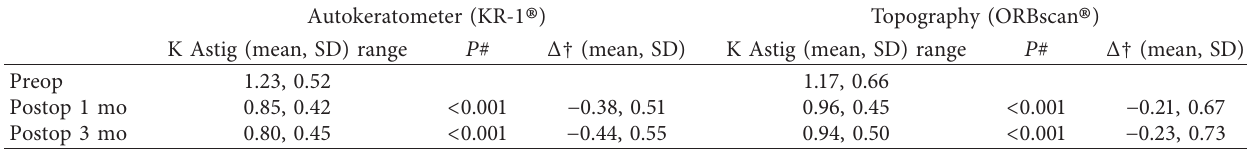
Table 2: Corneal astigmatism values recorded preoperatively and at 1 and 3 months postoperatively. Autokeratometer (KR-1 ® )